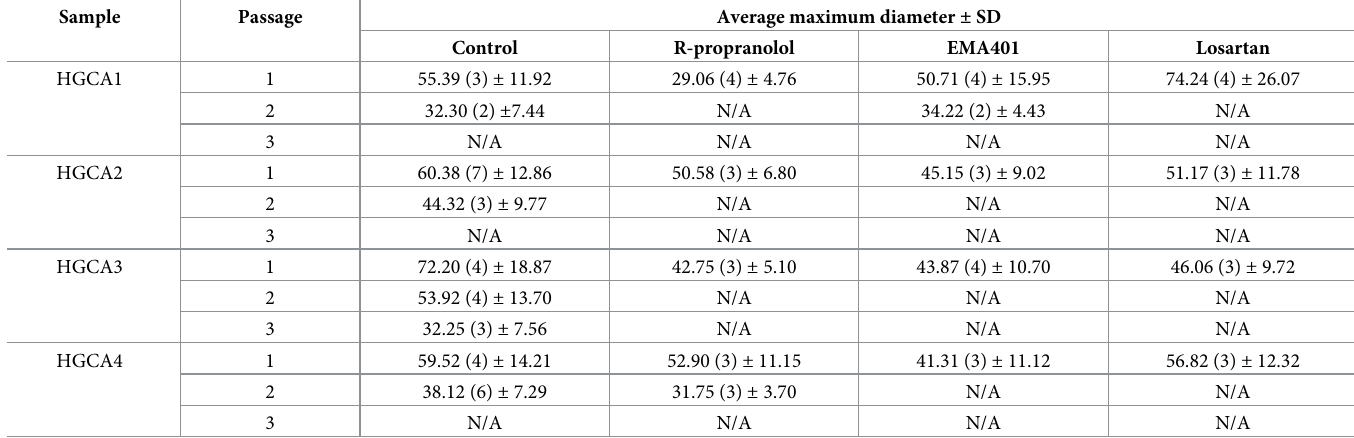
Primary cell lines derived from 4 HGCA tissue samples were exposed to 3 RAS modulators before being seeded for tumorsphere assays. Tumorsphere diameter was measured in μ m. The number of days taken to reach the maximum diameter are shown in brackets. Diameter values represent the average diameter of all measured tumorspheres across multiple technical replicates for each biological replicate, with SD values shown.